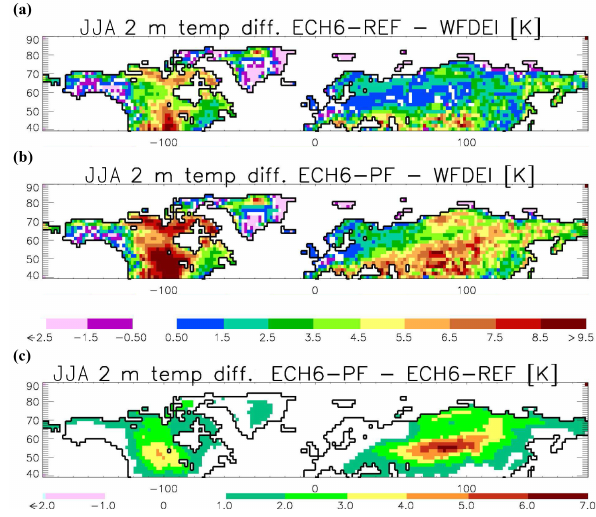
Figure 2. Boreal summer (JJA) 2m temperature differences (K) to WFDEI data for (a) ECH6-REF, (b) ECH6-PF, and (c) difference between ECH6-PF and ECH6-REF.